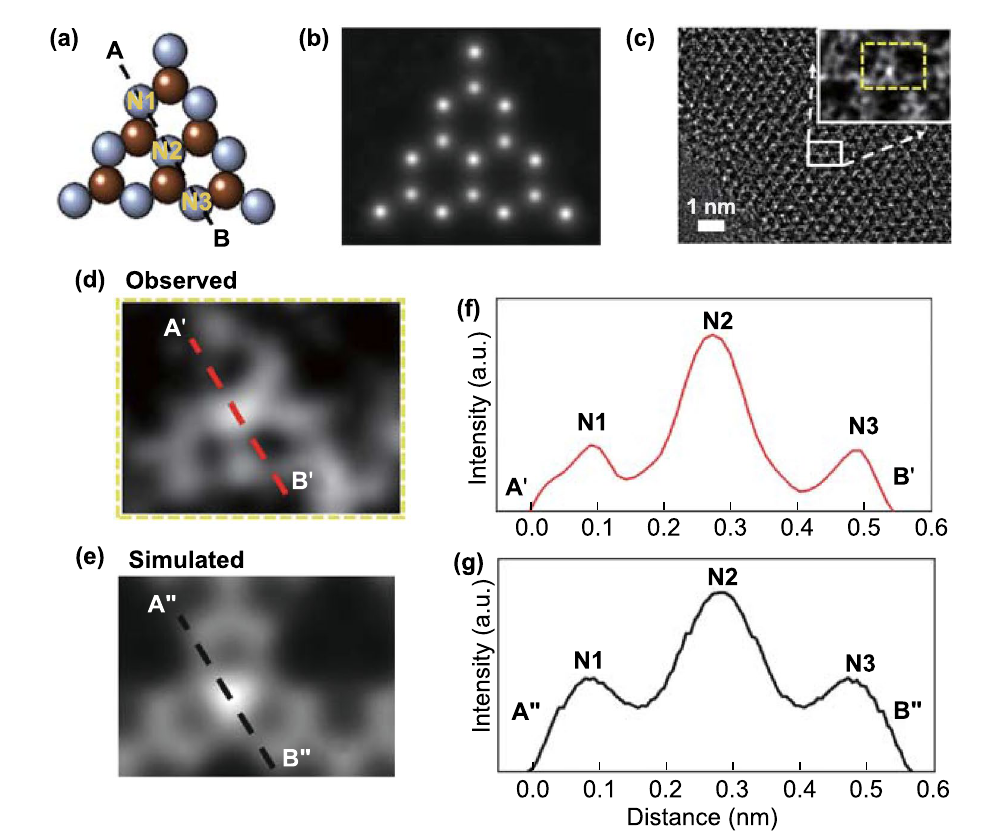
Fig. 4 Experimentally observed and theoretically simulated atomic structures of g‑C 3 N 4 –m. a A structure model and b an exit wave function. c Wiener‑filtered Cs‑HRTEM image of g‑C 3 N 4 –m. d A Cs‑HRTEM image magnified from the yellow‑dashed box in c, inset. e A corresponding simulation image for a tri‑s‑triazine unit. f, g Cross‑sectional profiles on the dashed line in d and e. The dashed line of A–B in a corresponds to the dashed lines of A’(A’’)‑B’(B’’) in f and